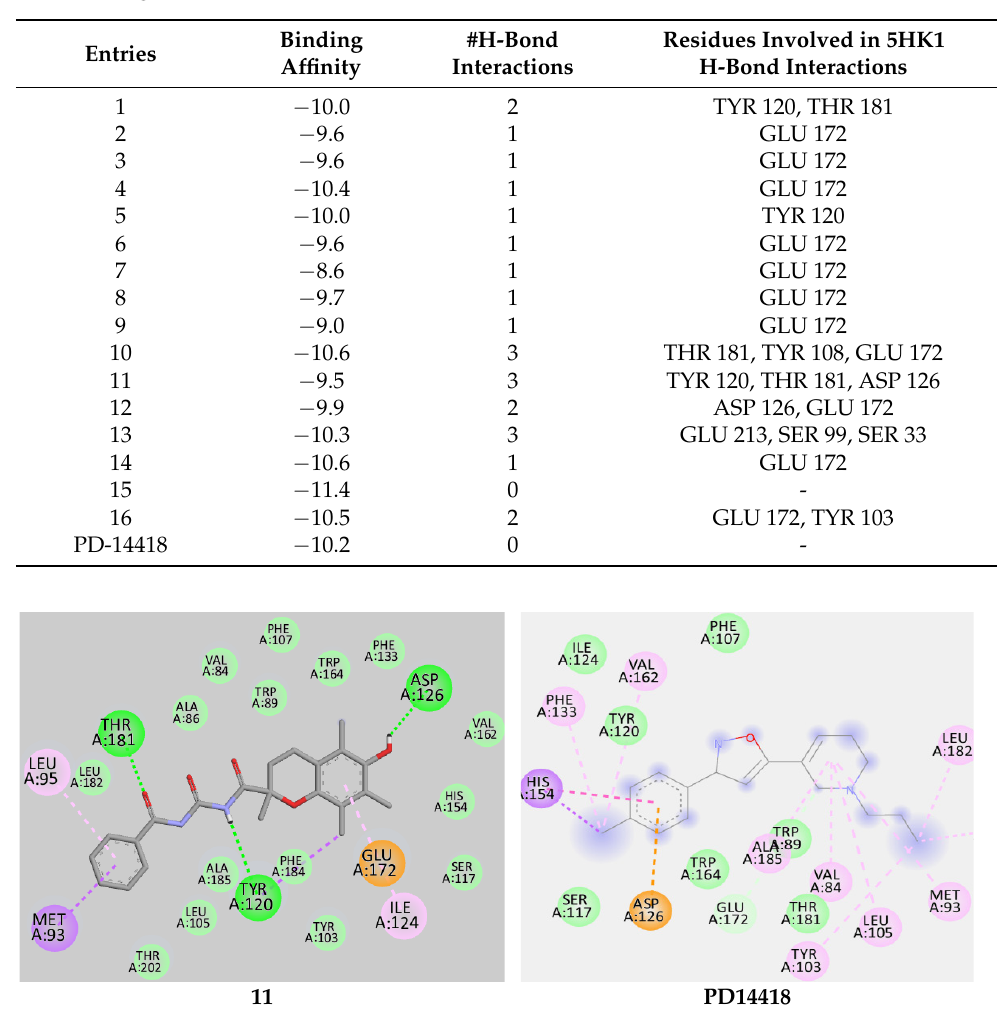
Table 3. PyRx generated binding affinity values, and the number of H-bonds and residue(s) involved in H-bonding.